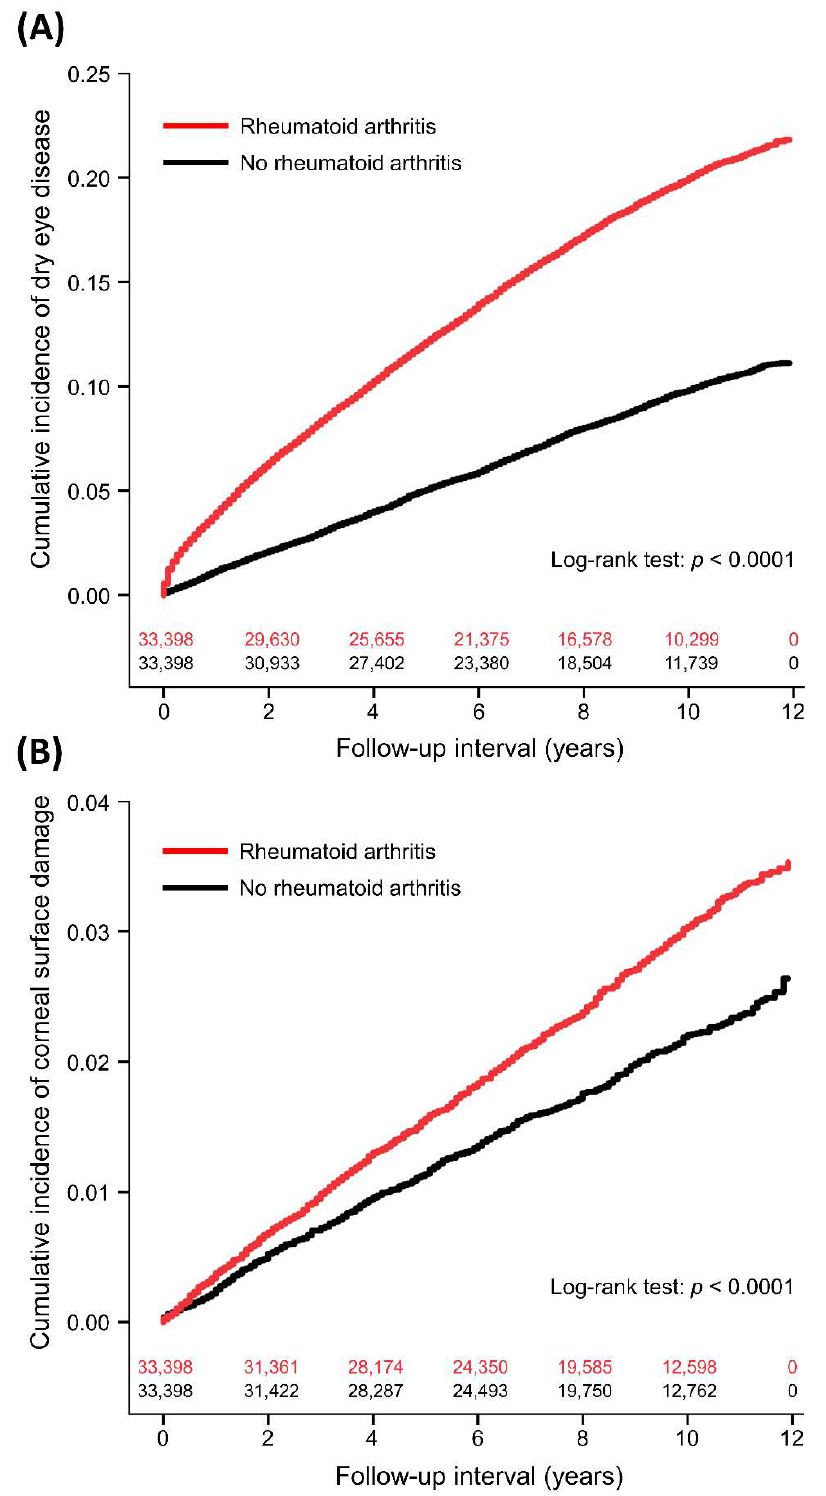
Figure 1. Cumulative incidence of dry eye disease ( A ) and corneal surface damage ( B ) between patients with and without rheumatoid arthritis with number of subjects at risk.